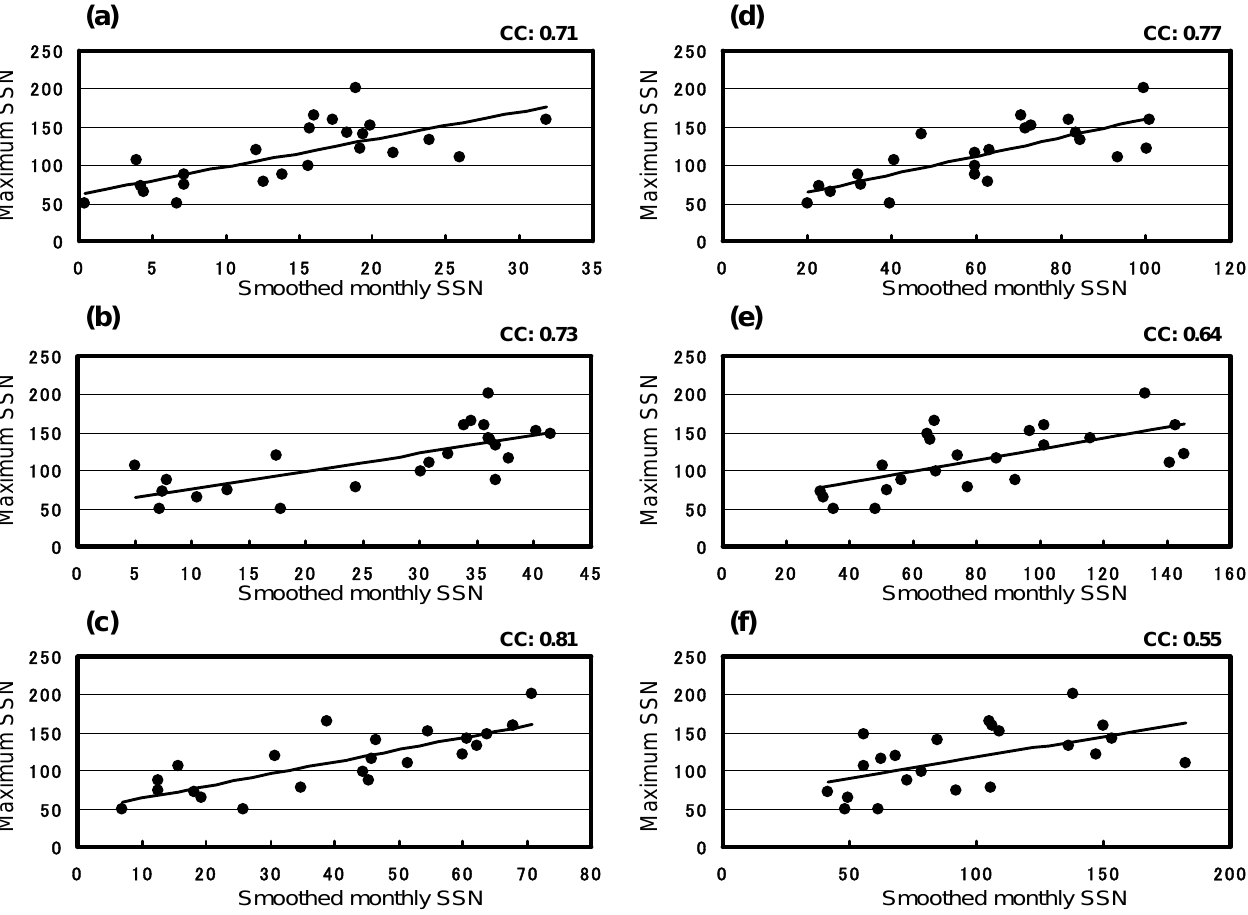
Fig. 4. (a) Peak sunspot number in the succeeding cycle versus monthly smoothed sunspot number one year before the minimum. Panels (b) , (c) , (d) , (e) and (f) are the same as panel (a) but for two-year, three-year, four-year, five-year and six-year periods before the minimum,